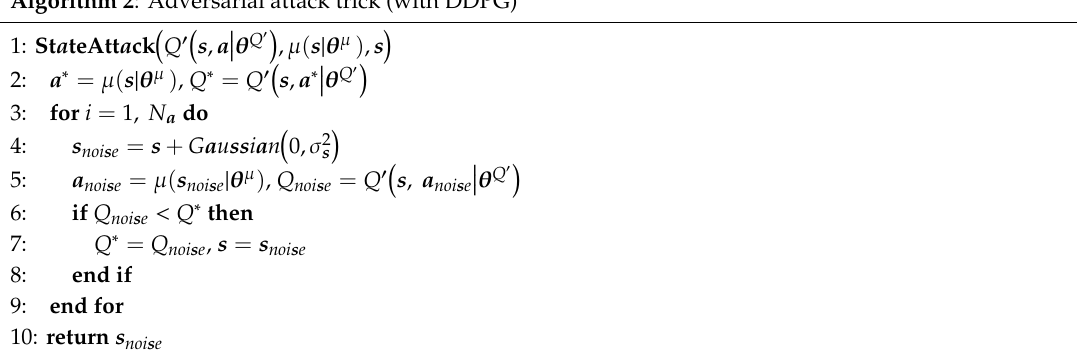
Algorithm 2 : Adversarial attack trick (with